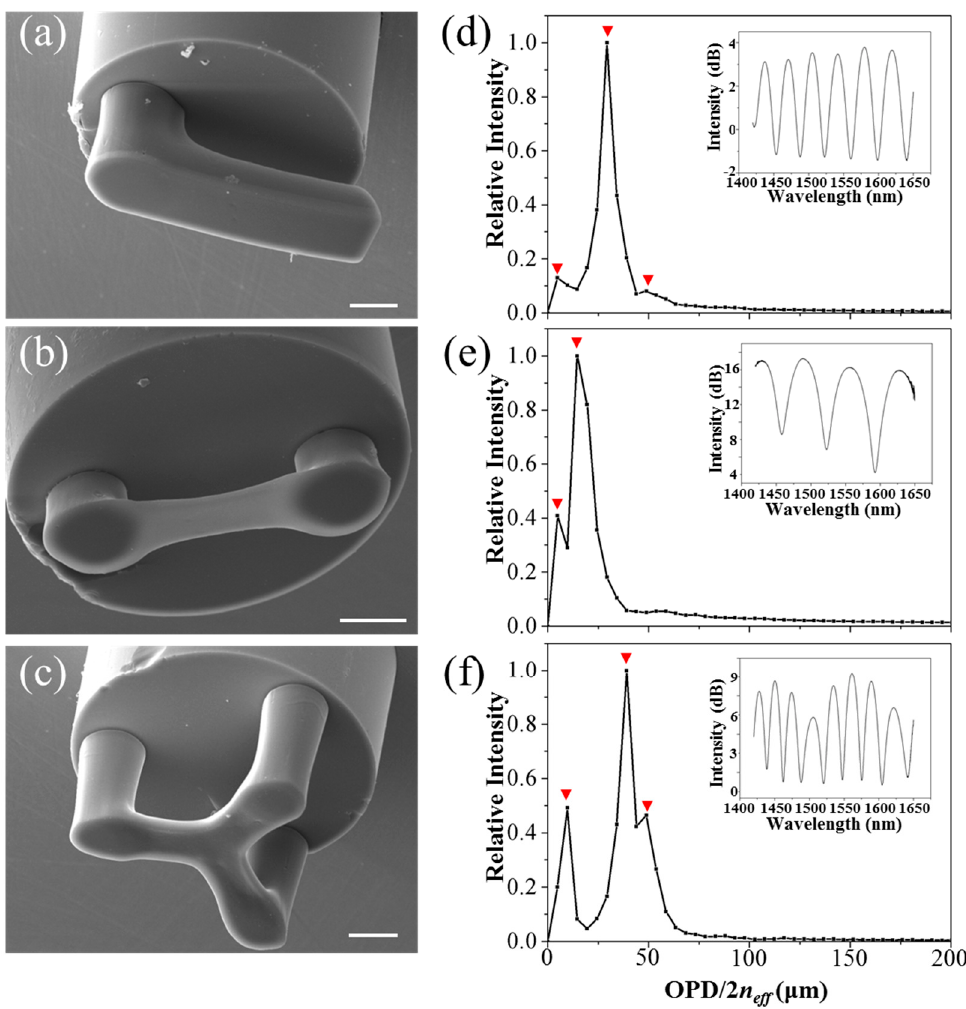
Figure 3. ( a ), ( b ), and ( c ) Scanning electron microscope (SEM) images of SU-8 suspended-microbeams printed on the end face of optical fibers. All scale bars are 20 µm. ( d ), ( e ), and ( f ) FFT’s results of the corresponding reflection spectra of optical fiber-tip sensors shown in ( a ), ( b ), and ( c ). Insets are the reflection spectra measured in air.